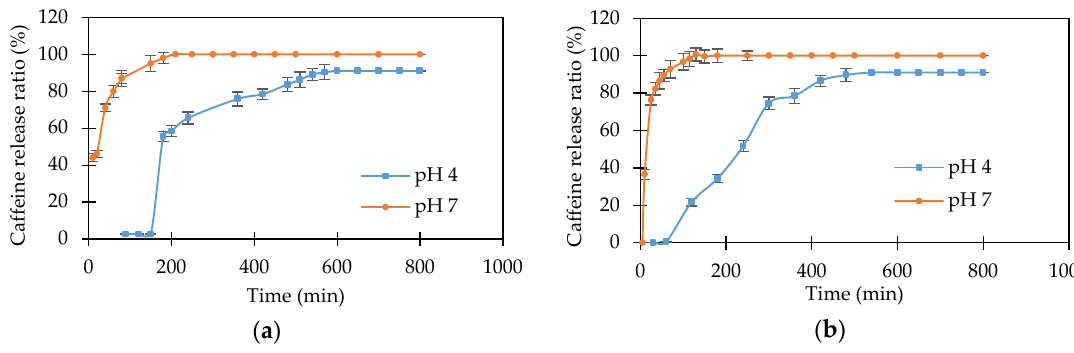
10 of 14 Figure 7. Drug release for caffeine into pH 4 and pH 7 buffer solution: ( a ) HEMA/AA/AAm; ( b ) HEMA/AA/MBA.